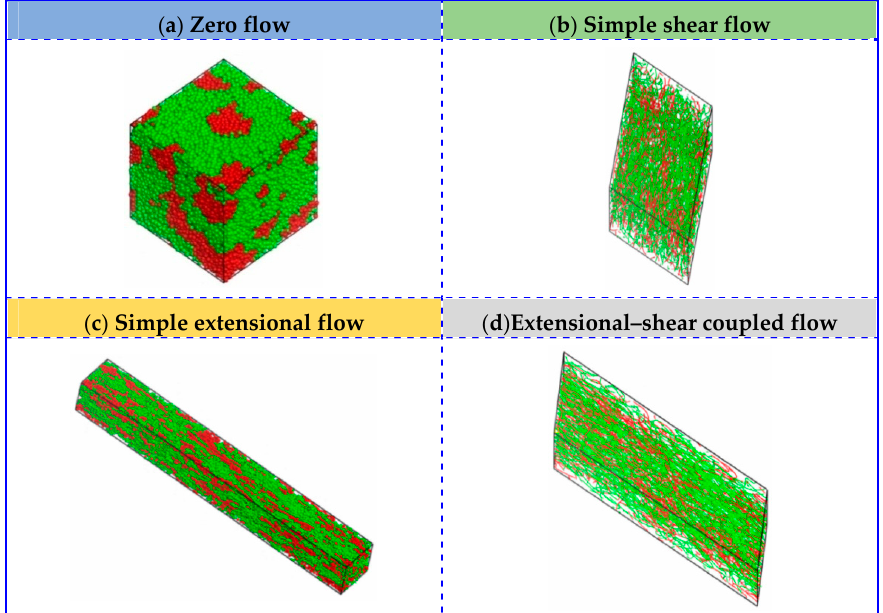
Figure 5. Comparison of UHMWPE/PA6 blends of 70/30 mass fractions under zero flow, simple shear flow, simple extensional flow and extensional–shear coupled flow.( b , d ) are displayed in line style and the others are presented in dot-line style. Polymers 2019 , 11 , x FOR PEER REVIEW